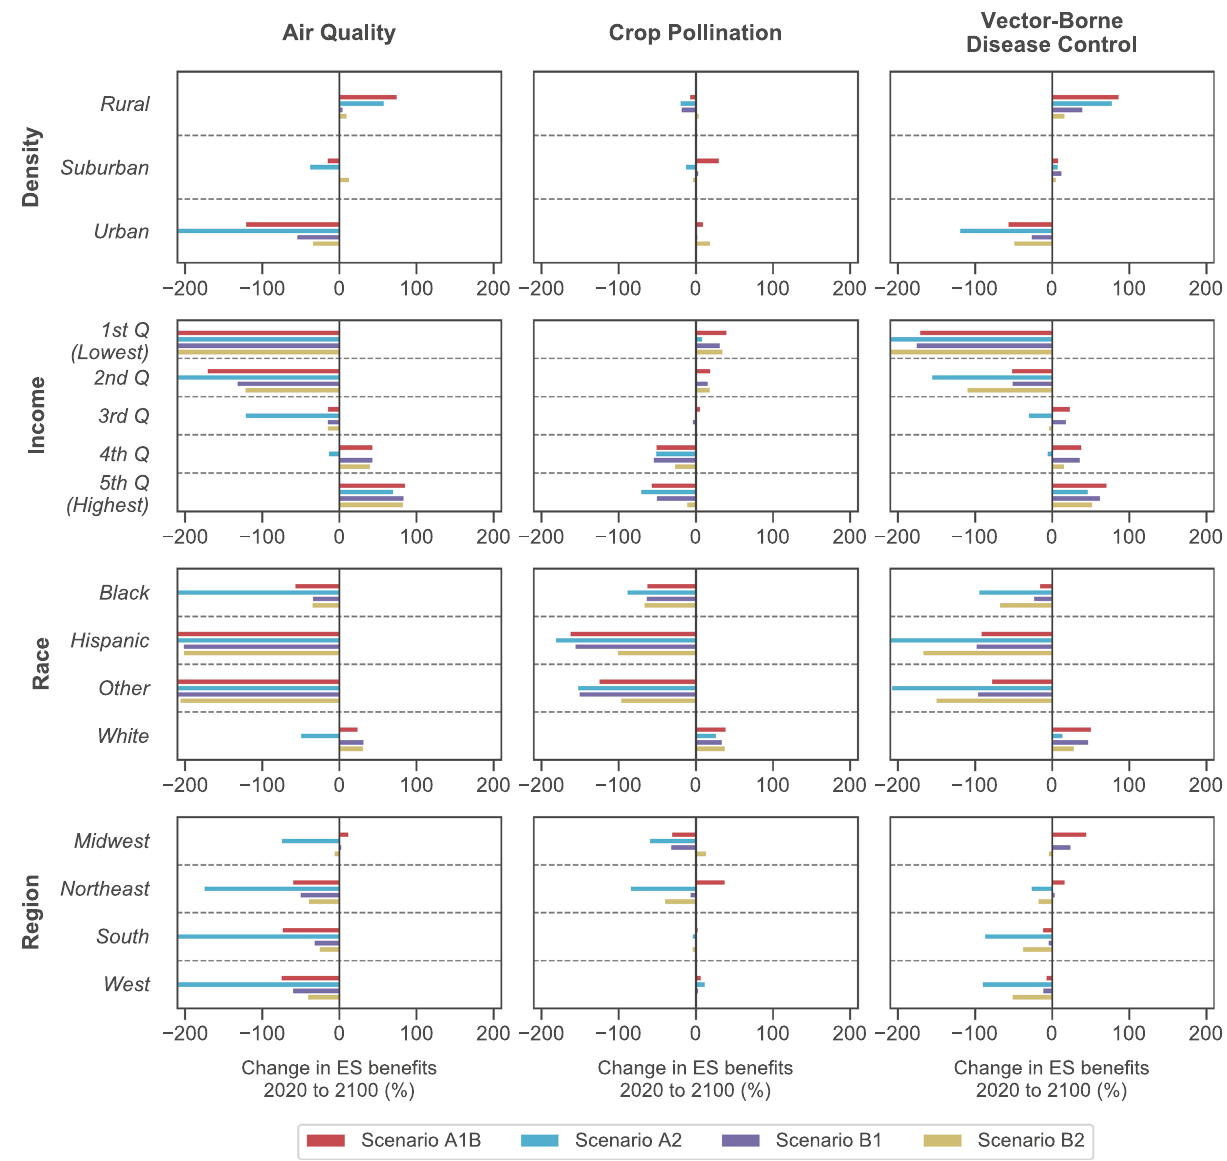
Fig. 4 Distribution of percent changes in ES bene fi ts, between 2020 and 2100, across various groups of bene fi ciaries. Projections vary by IPCC SRES scenario, as indicated by the color of the bars. The lower and upper limits of the x -axis for each subplot are set to − 210 and 210 to facilitate comparison across subplots; however, some bars extend beyond these